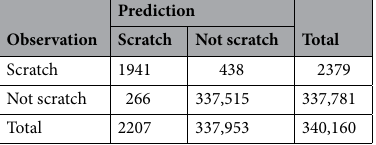
Table 2. Confusion matrix for test dataset.